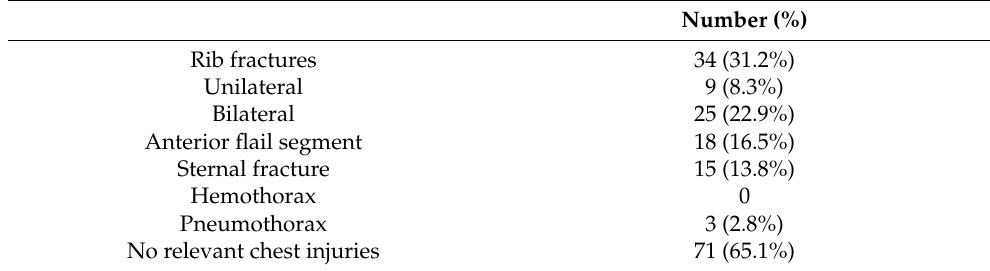
Table 2. CPR-related thoracic injuries, detected by thoracic CT imaging or chest